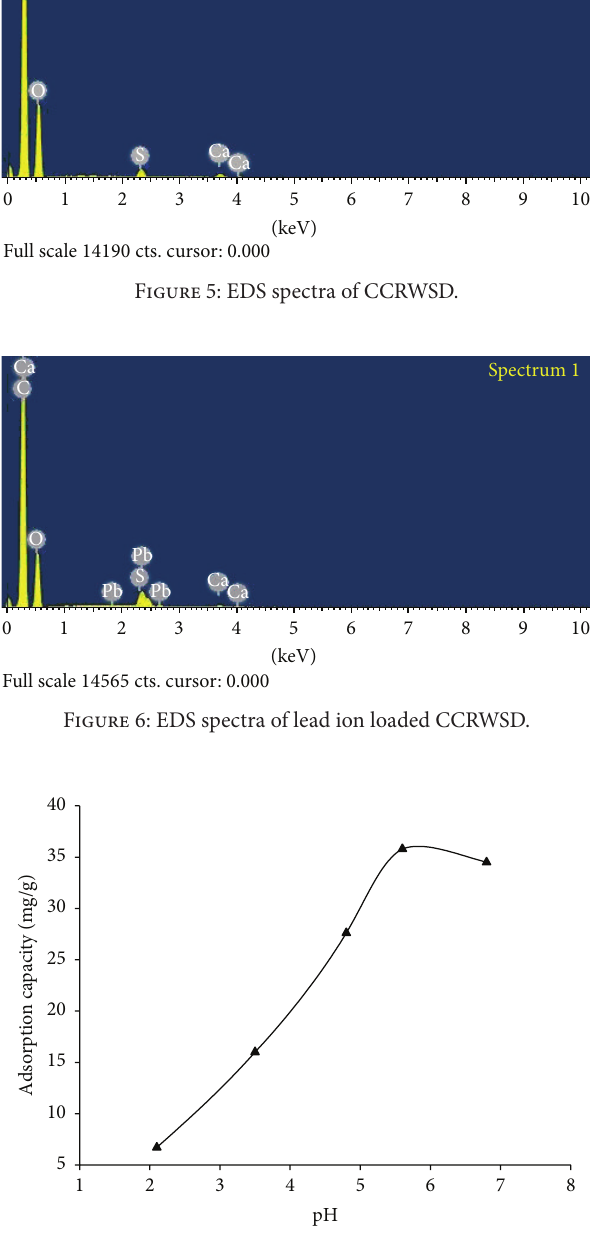
Figure 7: Effect of pH on the adsorption of lead ions onto CCRWSD ( 𝐶 0 = 20 mg/L, dose = 0.5 g/L, contact time = 120min, and temperature = 30 ∘